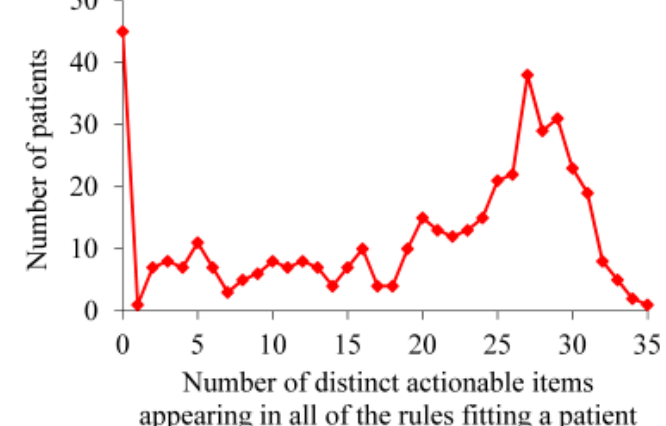
Figure 4. Distribution of patients by the number of distinct actionable items appearing in all of the rules fitting a patient for the patients with asthma whom our extreme gradient boosting model correctly predicted to incur asthma hospital visits in the subsequent